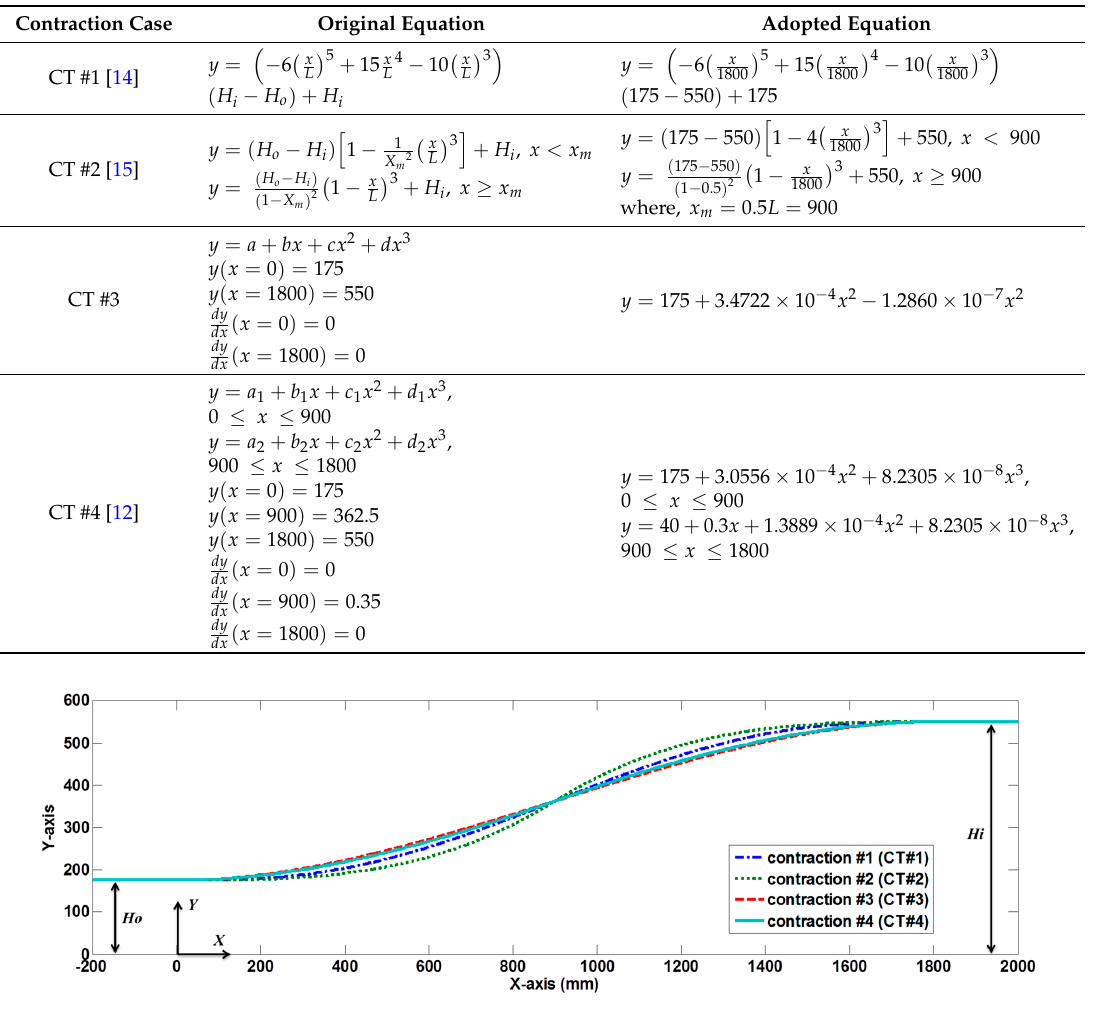
Figure 1. Four investigated contraction wall shapes.